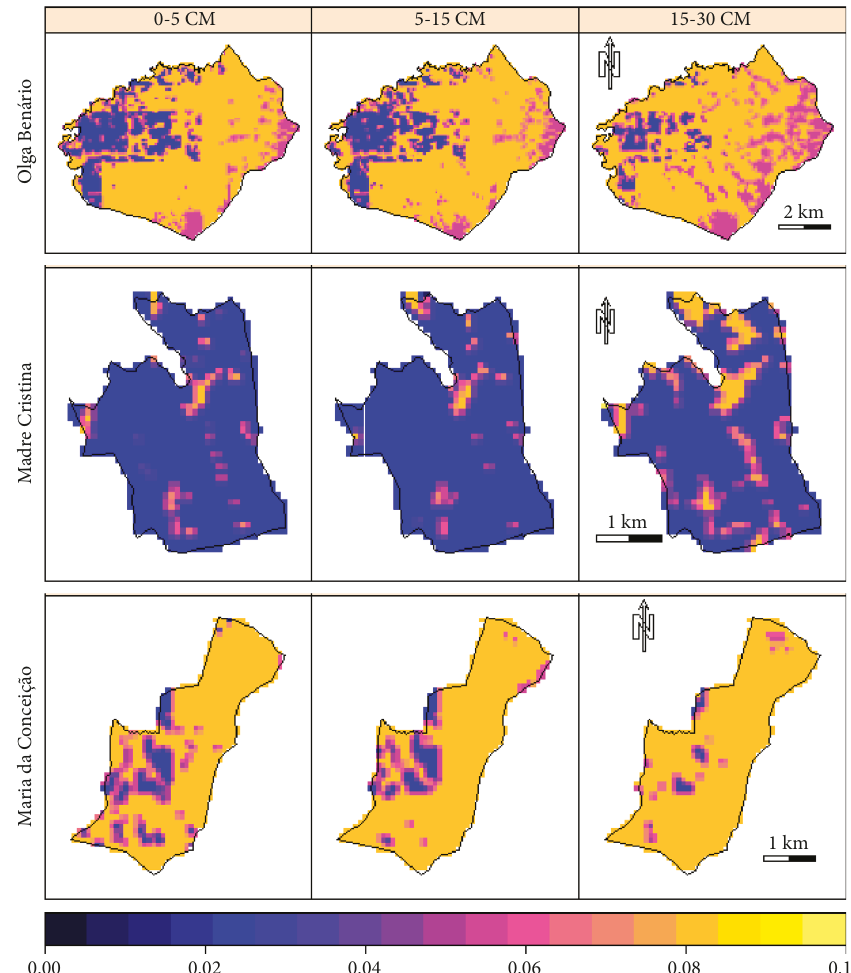
Figure 2: Estimates of S index for three rural settlement areas in the southeast of Goi´as, Brazil, in three depth layers: 0–5, 5–15, and